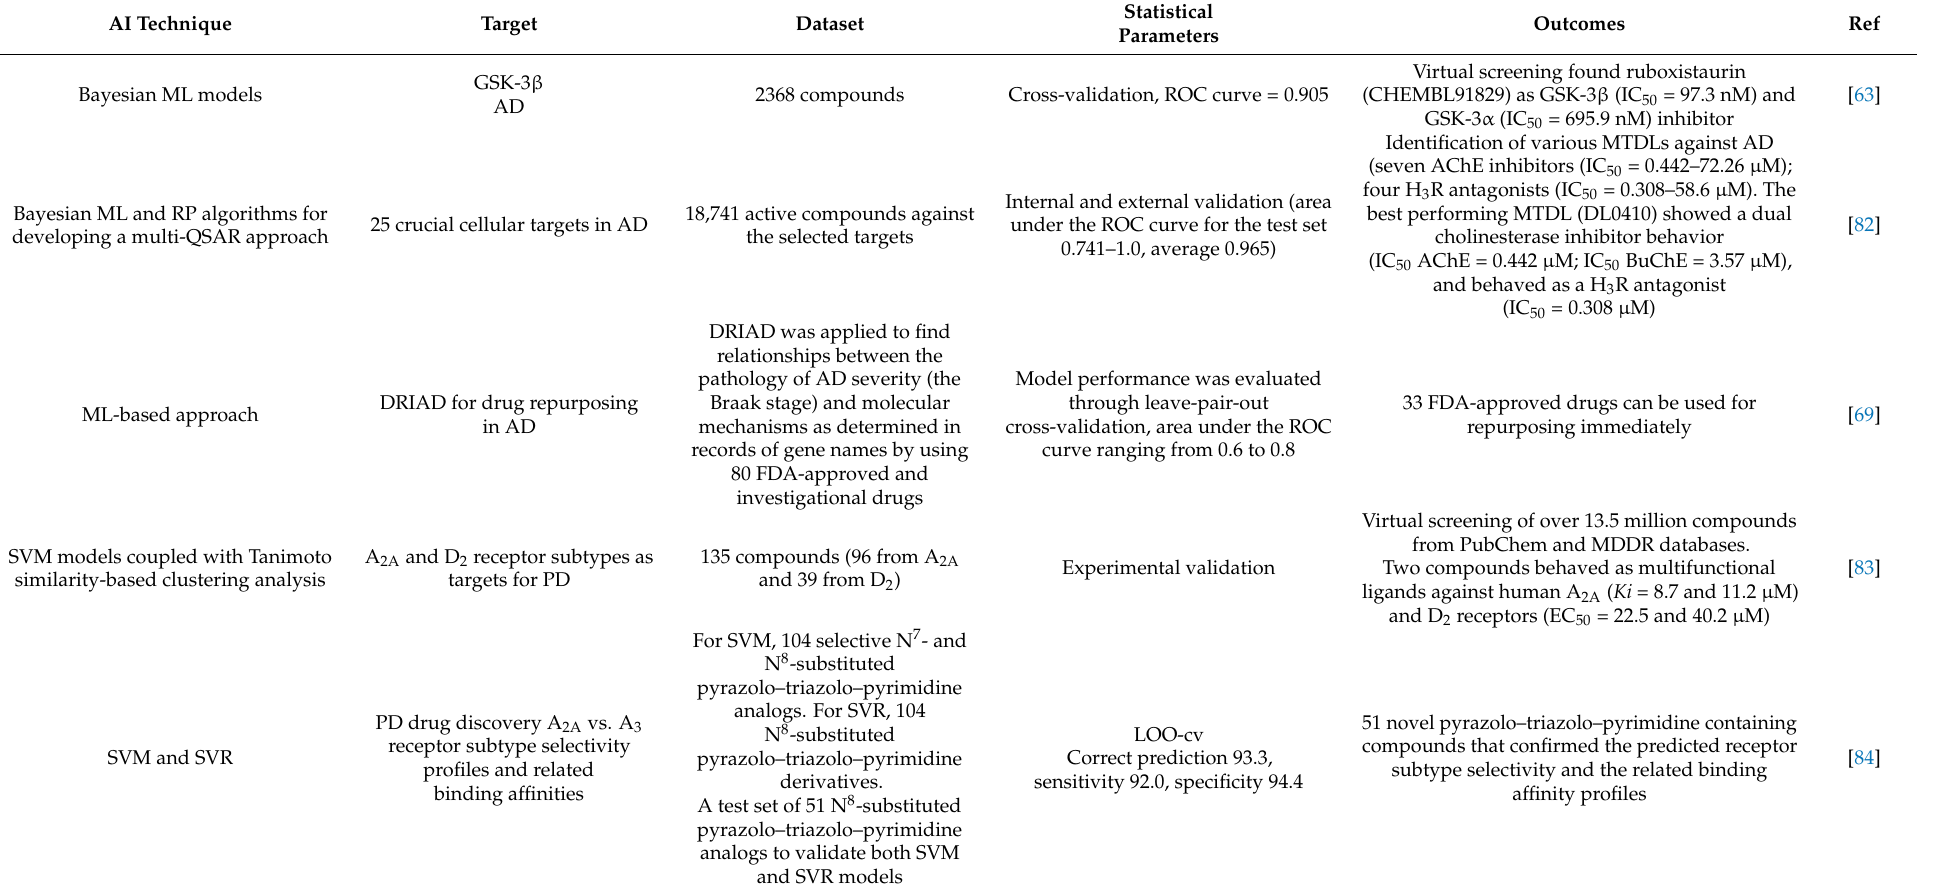
Table 1. Main examples of AI/ML in the drug discovery and development